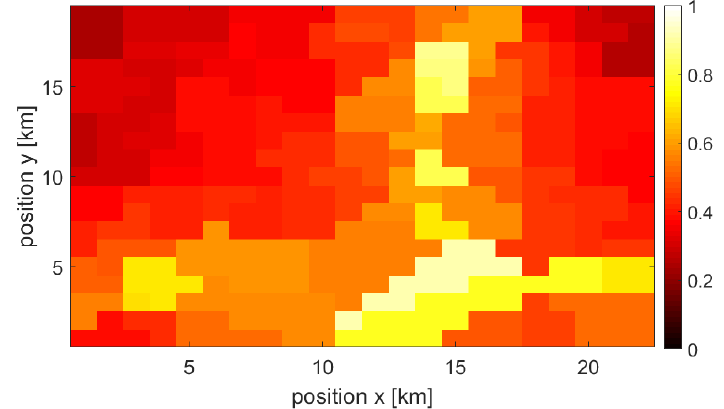
Figure 4. Example of a user density map created by power sensor